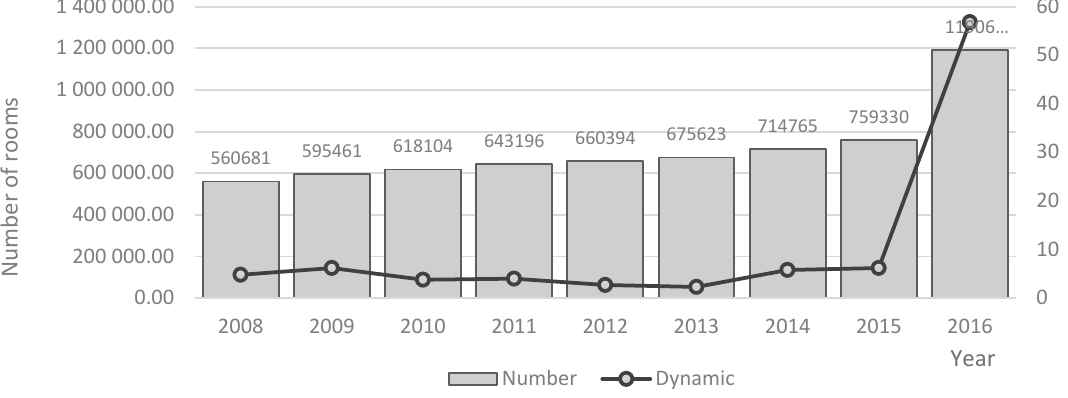
Figure 5. Dynamic of the number of rooms in a hotel chain Marriott,